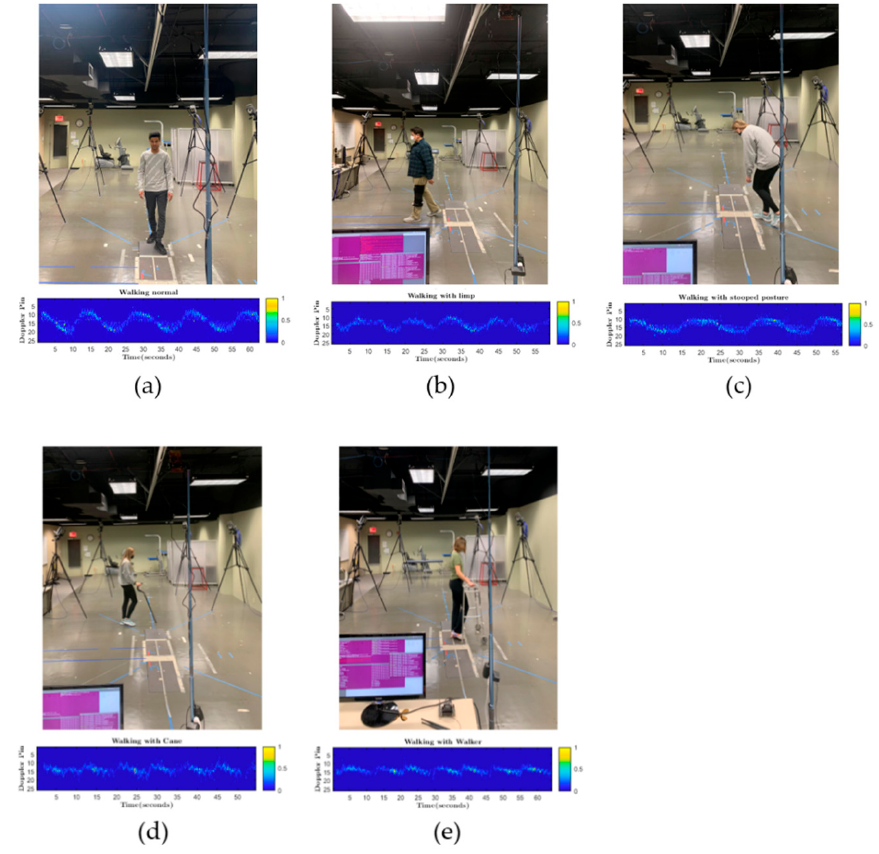
Figure 10. Micro-Doppler spectrogram produced during the data collection process for different activities. ( a ) walking normal, ( b ) walking with limp, ( c ) walking with stooped posture, ( d ) walking with a cane, ( e ) walking with a walker.